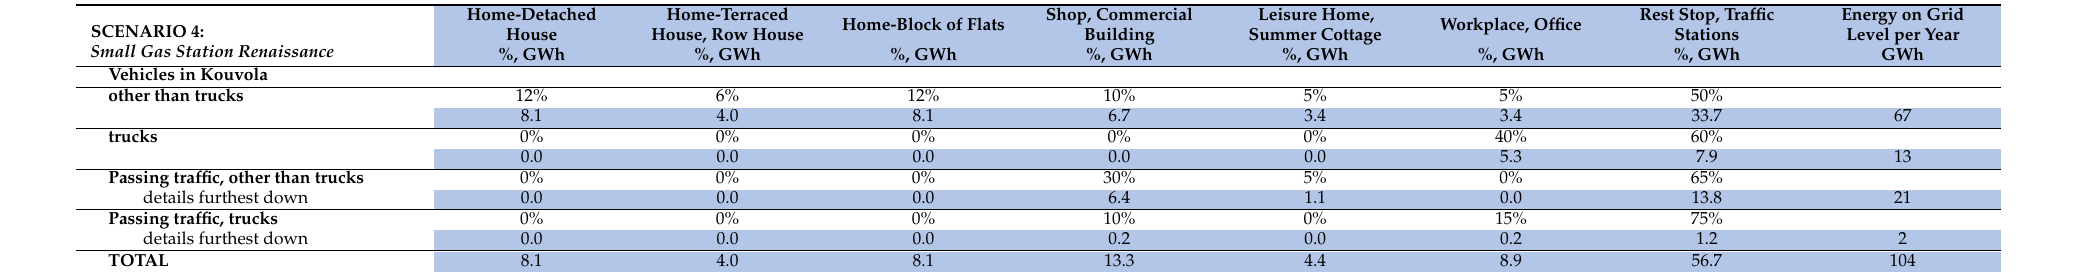
Table A11. Kouvola-based and passing traffic: subdivision of additional energy into user groups. Percentages indicate the share of consumption